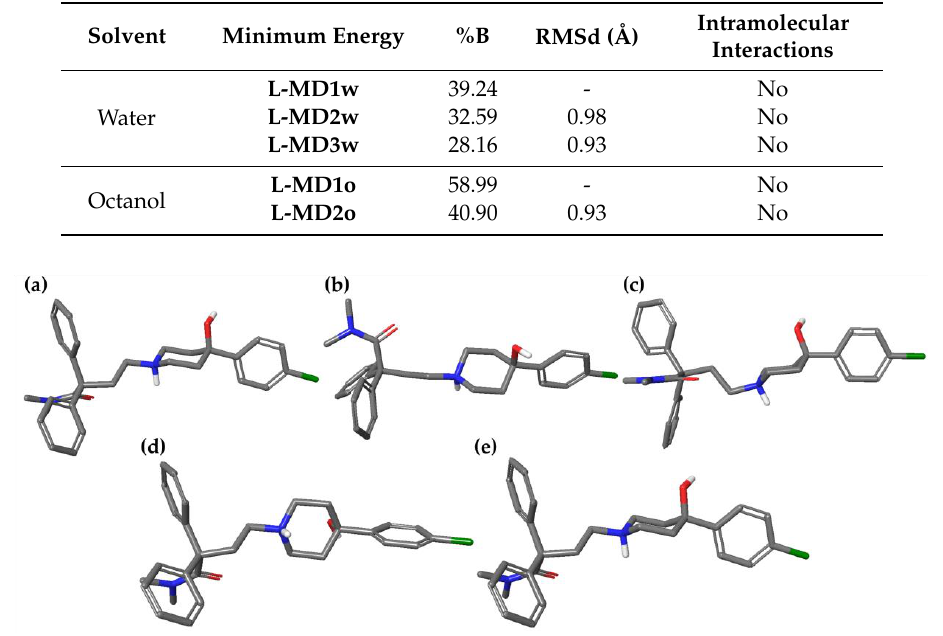
Figure 2. Three-dimensional structures of the best energy minima (%B > 10%) of loperamide (L), obtained after MD simulations conducted in both solvents. ( a ) L-MD1w , ( b ) L-MD2w , ( c ) L-MD3w , obtained after MD simulations conducted in both solvents. ( a ) L-MD1w, ( b ) L-MD2w, ( c ) L-MD3w, ( d ) L-MD1o and ( e ) L-MD2o ( d ) L-MD1o and ( e ) L-MD2o .